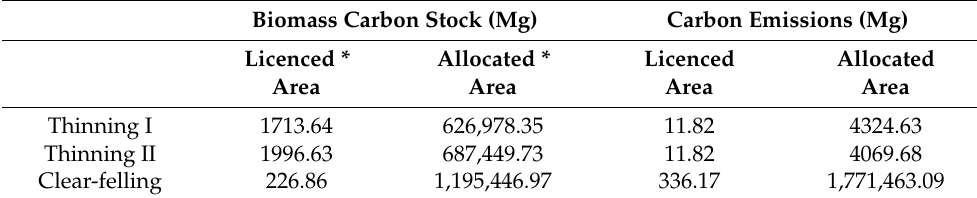
Table 4. Comparison between carbon stock in the vegetation biomass and carbon emissions over a period of 30 years for the productive forest in the MMFR. For the carbon stock, the values were calculated based on 15-, 20- and 30-year-old forest stands AGB values (163.5 Mg ha − 1 , 190.5 Mg ha − 1 , * Licensed area = 2.2 ha for charcoal and 22.3 ha for poles. * Allocated area = total area reported by the current 219.4 Mg ha − 1 , respectively) following the age of thinning and clear-felling reported by the last man- management plan for felling (8159 and 7678 ha for first and second thinning, respectively, and 11,593 ha for agement plan. final